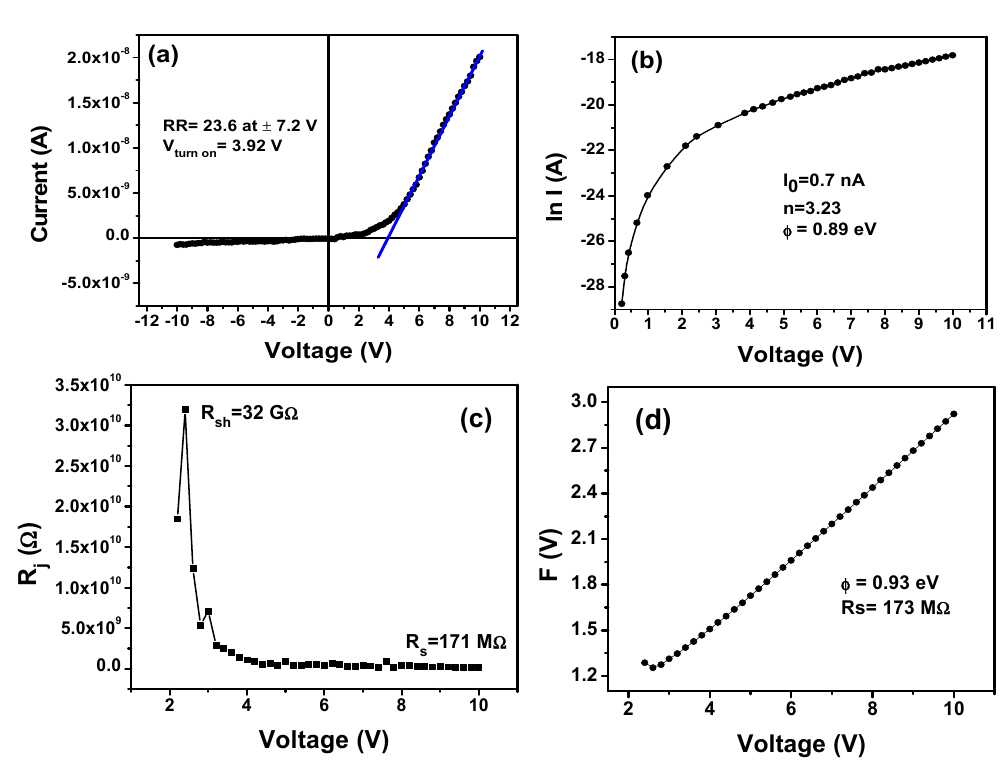
Figure 4. ( a ) I–V curves at room temperature, ( b ) ln (I)–V characteristics, ( c ) junction resistance vs. V curve, and ( d ) F(V) vs. V plot for the Ag/PFB/p-Si device.